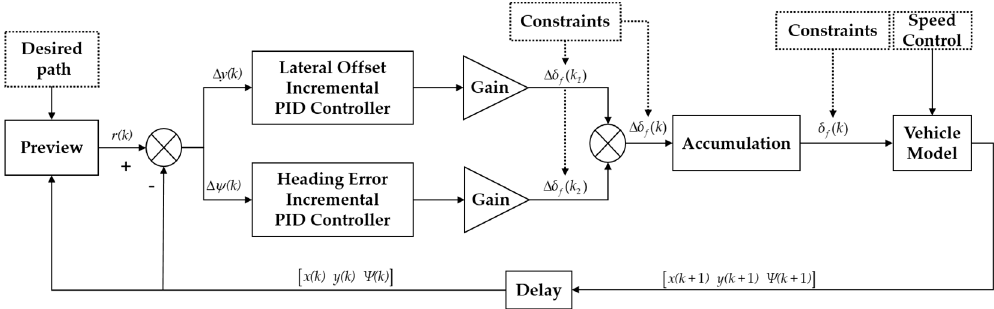
Figure 2. Architecture of path tracking controller.